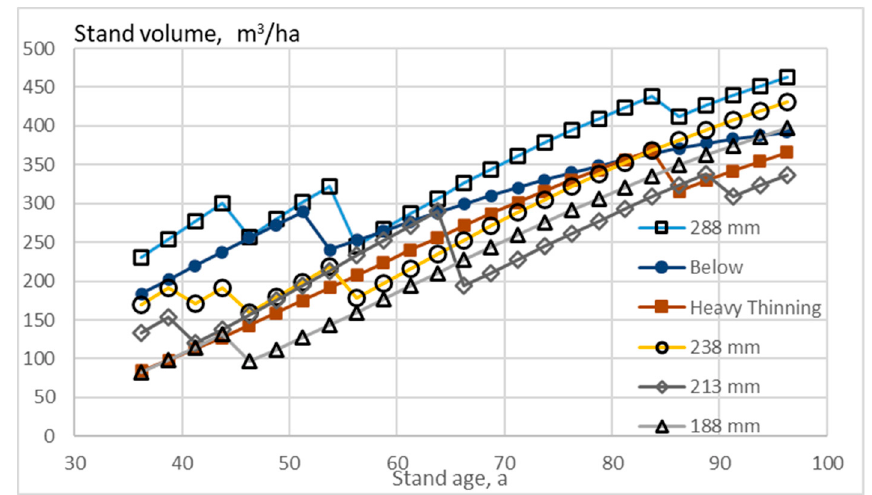
Figure 4. Commercial stand volume for six different treatments applied on a normal stand representing the example estate. A representative stand volume is computed for any 30 ‐ month period, without integration over the site lifespan.